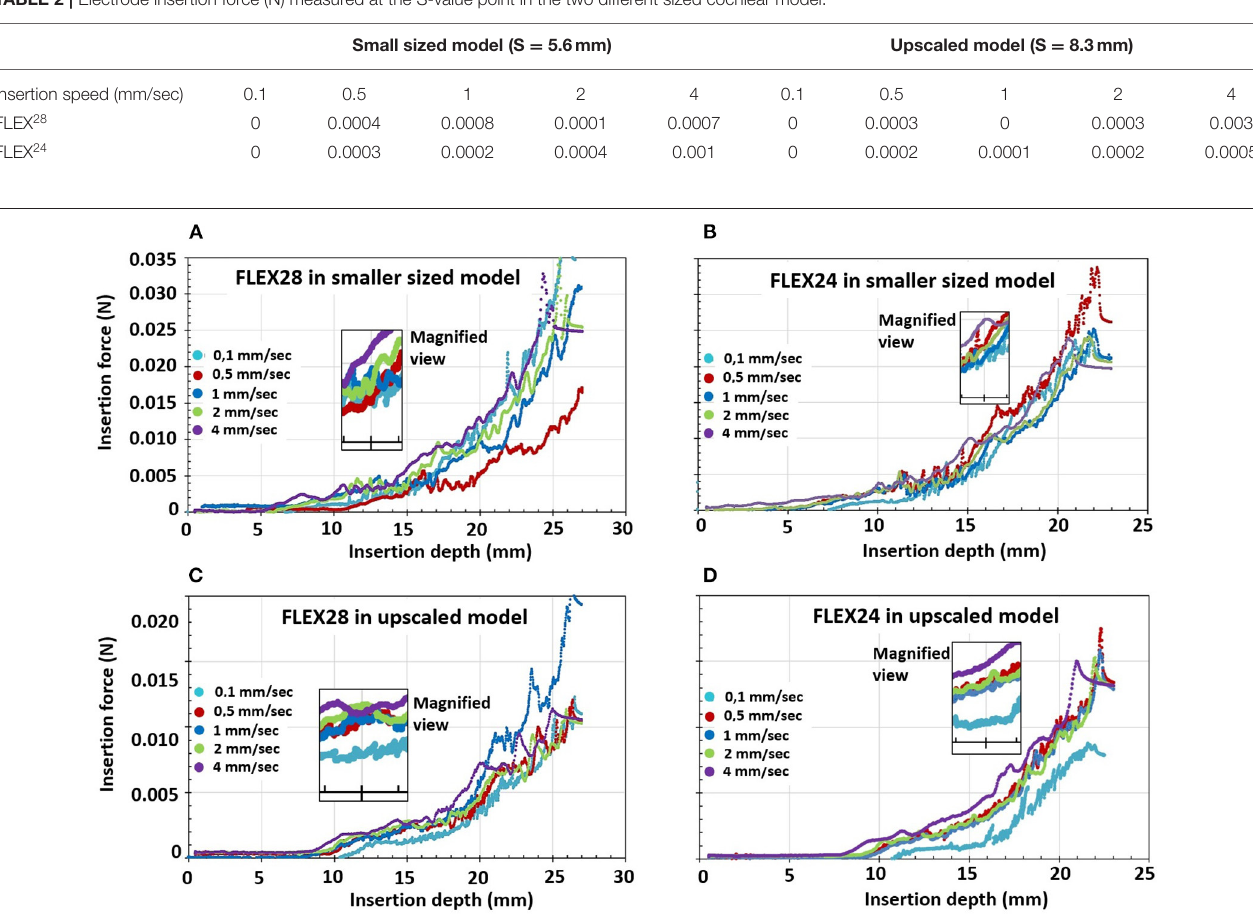
TABLE 2 | Electrode insertion force (N) measured at the S-value point in the two different sized cochlear model.